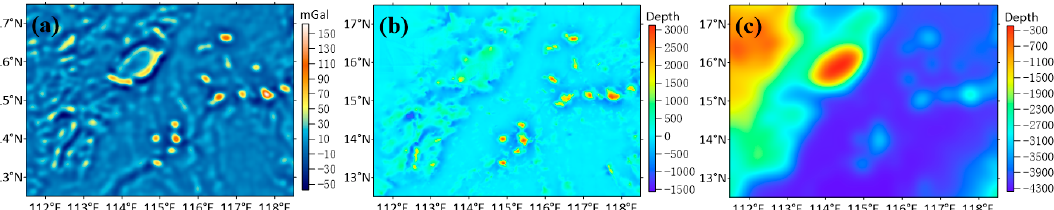
Figure 5. Filtering results for the gravity anomaly and seafloor topography: ( a ) band-pass filtering and downward continuation result for the gravity anomaly, ( b ) medium and short wavelengths for the seafloor topography, and ( c ) low-pass filtering result for the SIO seafloor topography.